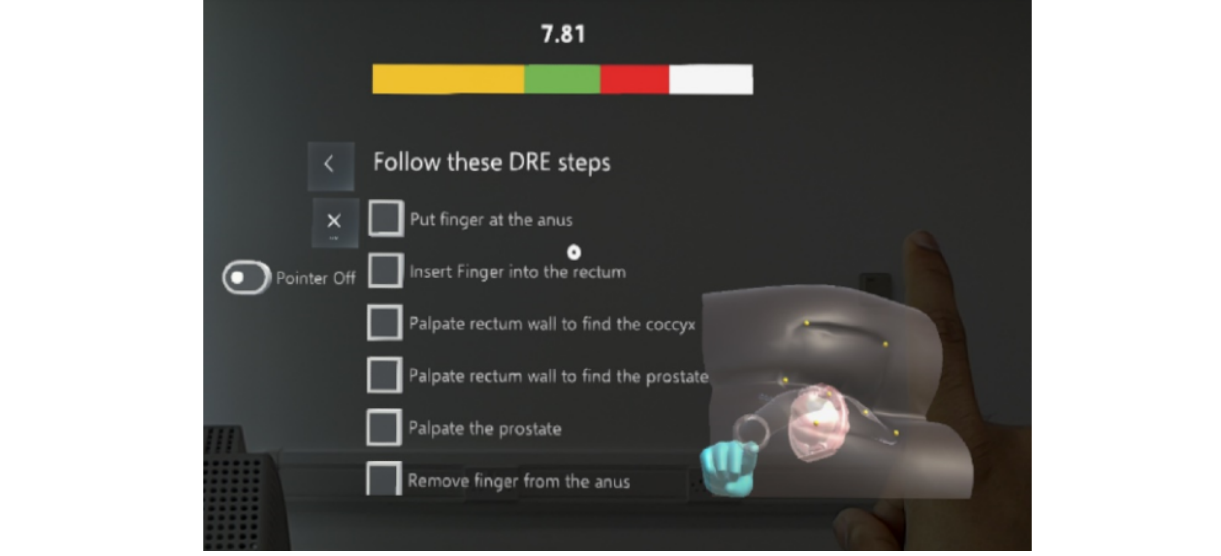
Figure 13. Step-by-step guidance next to the virtual benchtop model. DRE: digital rectal